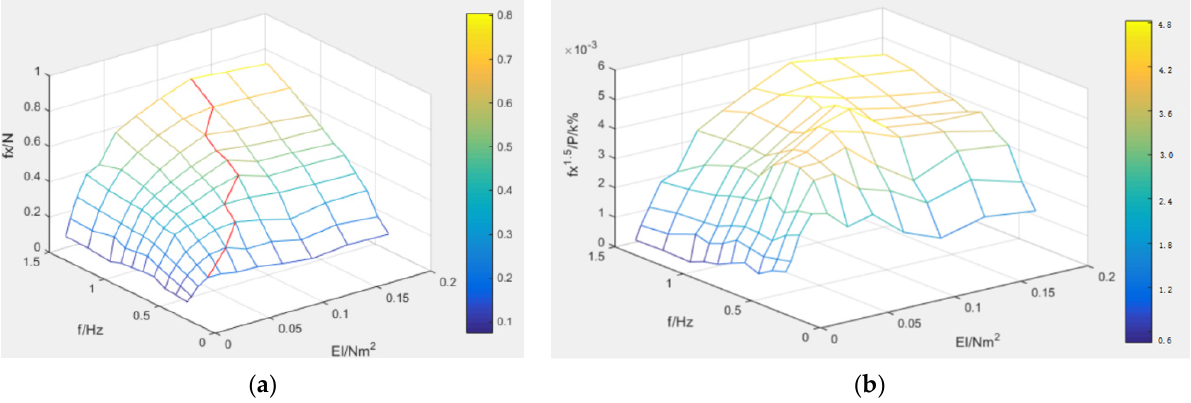
Figure 7. Coupling relationship between the stiffness and the swing frequency. ( a ) Thrust—frequency—bending stiffness diagram. The red line represents the bending stiffness at the highest thrust at different frequencies in the measured data. ( b ) Propulsion efficiency—frequency—bending stiffness diagram.